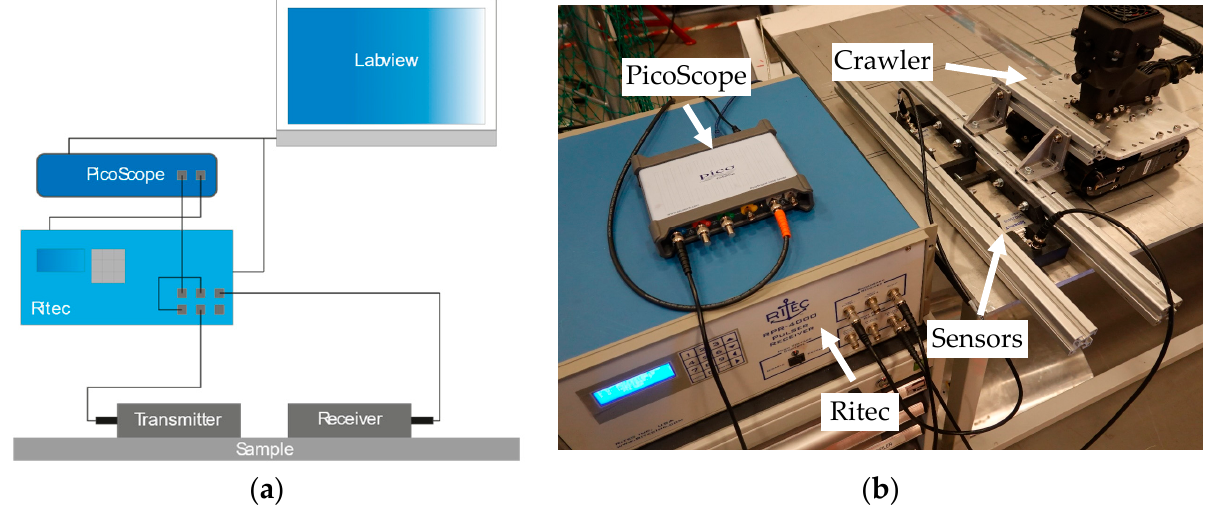
Figure 5. Experimental setup, shown diagrammatically ( a ) and practically ( b ). The Ritec pulses the EMATs and receives the resultant signals. The Picoscope is triggered to record this and feeds the information to the LabVIEW program so it can be analysed.